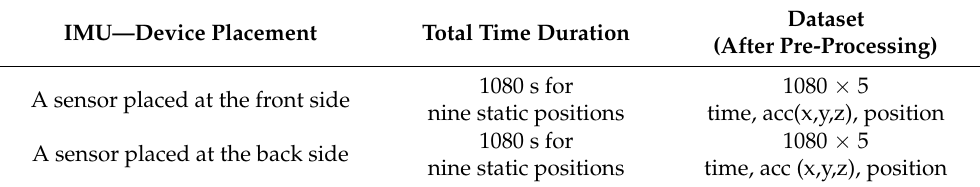
Table 2. Dataset quantitative parameters. IMU—Device Placement Total Time Duration